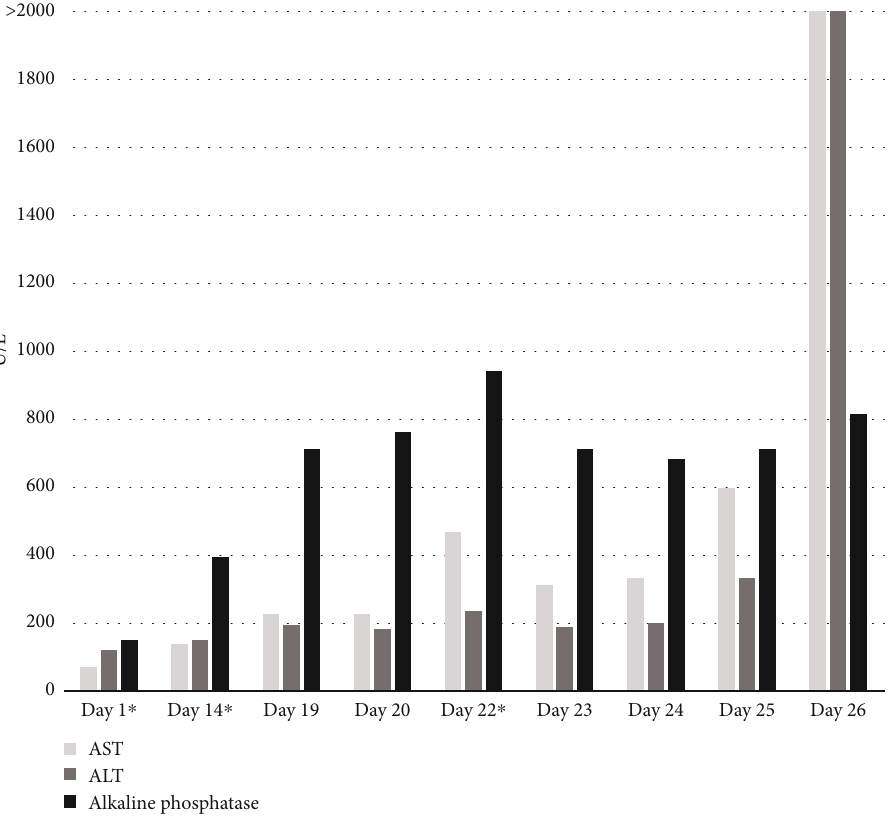
Figure 1: Liver function tests before, during, and after 2 cycles of nivolumab. The dates are numbered starting with the fi rst day of the fi rst cycle of nivolumab. AST: aspartate aminotransferase; ALT: alanine aminotransferase; day 1 ∗ : start of the 1 st cycle of nivolumab; day 14 ∗ : start of the 2 nd cycle of nivolumab; day 22 ∗ : 1 st dose of corticosteroids. The graph shows the rapid increase in liver function tests after the patient began taking nivolumab and the minor response after being treated with corticosteroids. It also depicts the timeline until the patient perspired.